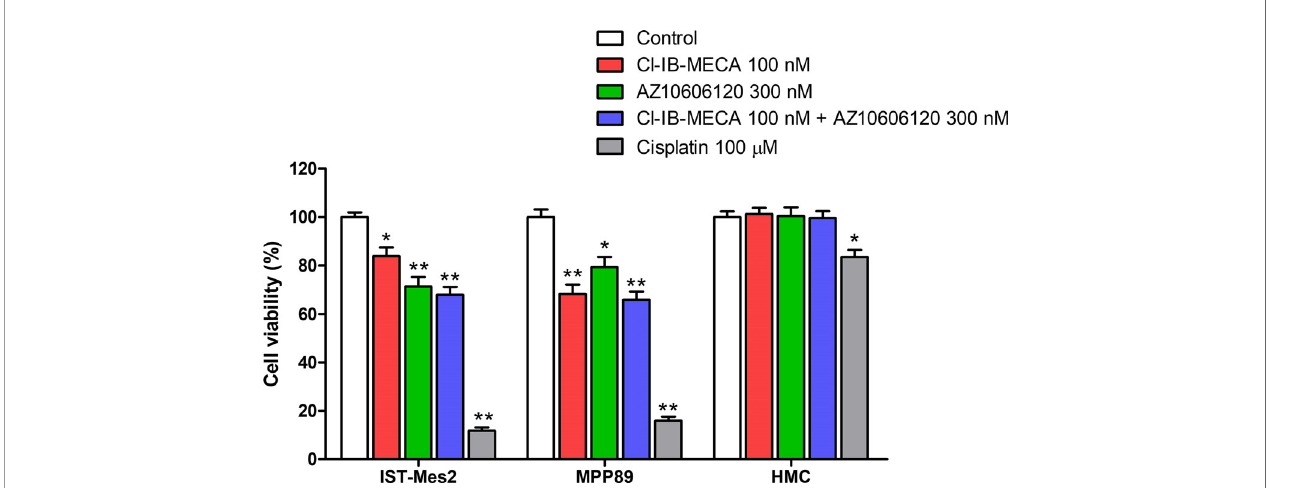
FIGURE 4 | MTT assays. Effect of Cl-IB-MECA (100 nM), AZ10606120 (300 nM), alone or in combination, in comparison to cisplatin 100 µM on cell viability in IST-Mes2 and MPP89 cells as well as in HMC cells. Results are represented as mean ± standard error of mean (SEM) of n=3 independent experimental replicates. *p < 0.05 vs control; **p < 0.01 vs